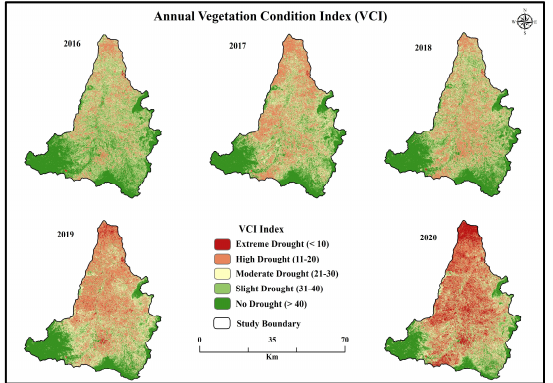
Figure7: Annual Vegetation Condition Index of 2016 to 2020